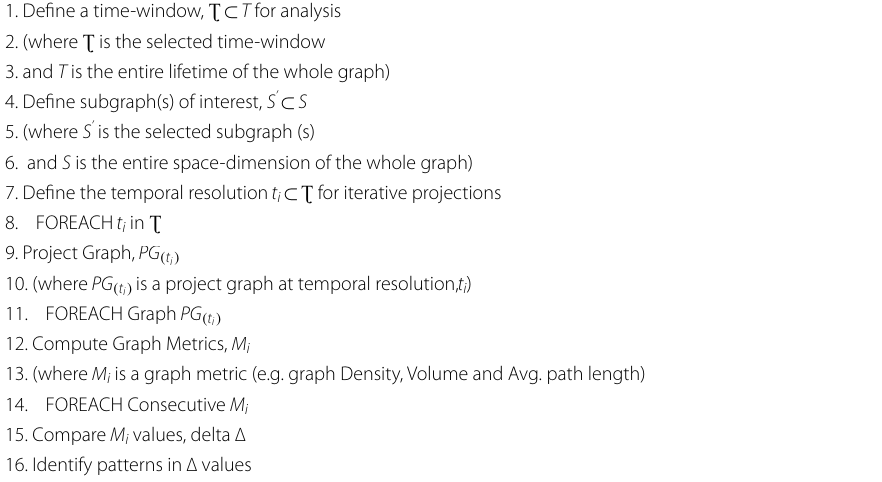
Table 1 Capturing the Whole graph evolution